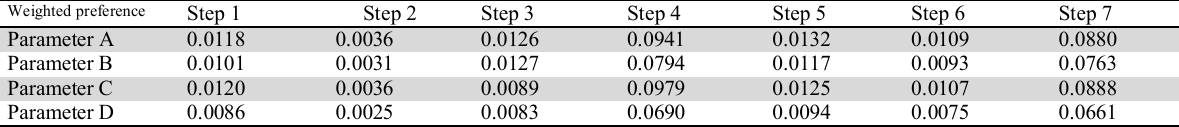
, which are shown in Table 9, are computed. (cid:3020)(cid:3047)(cid:3032)(cid:3043)(cid:3046)